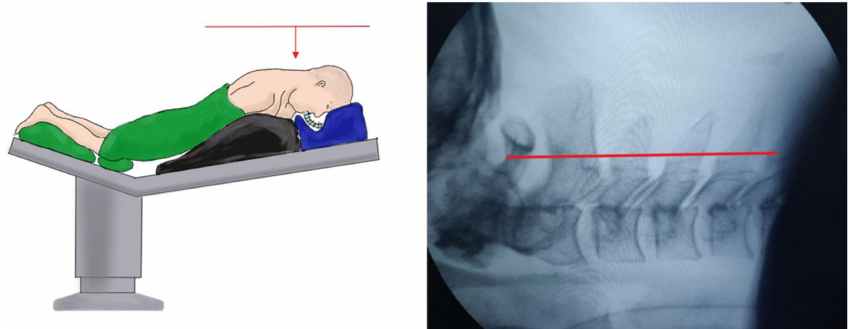
Figure 1. Surgical positioning and surgical posture requirements of UBE (unilateral biportal en- doscopic) and PE (percutaneous posterior endoscopic cervical discectomy) keyhole surgery.